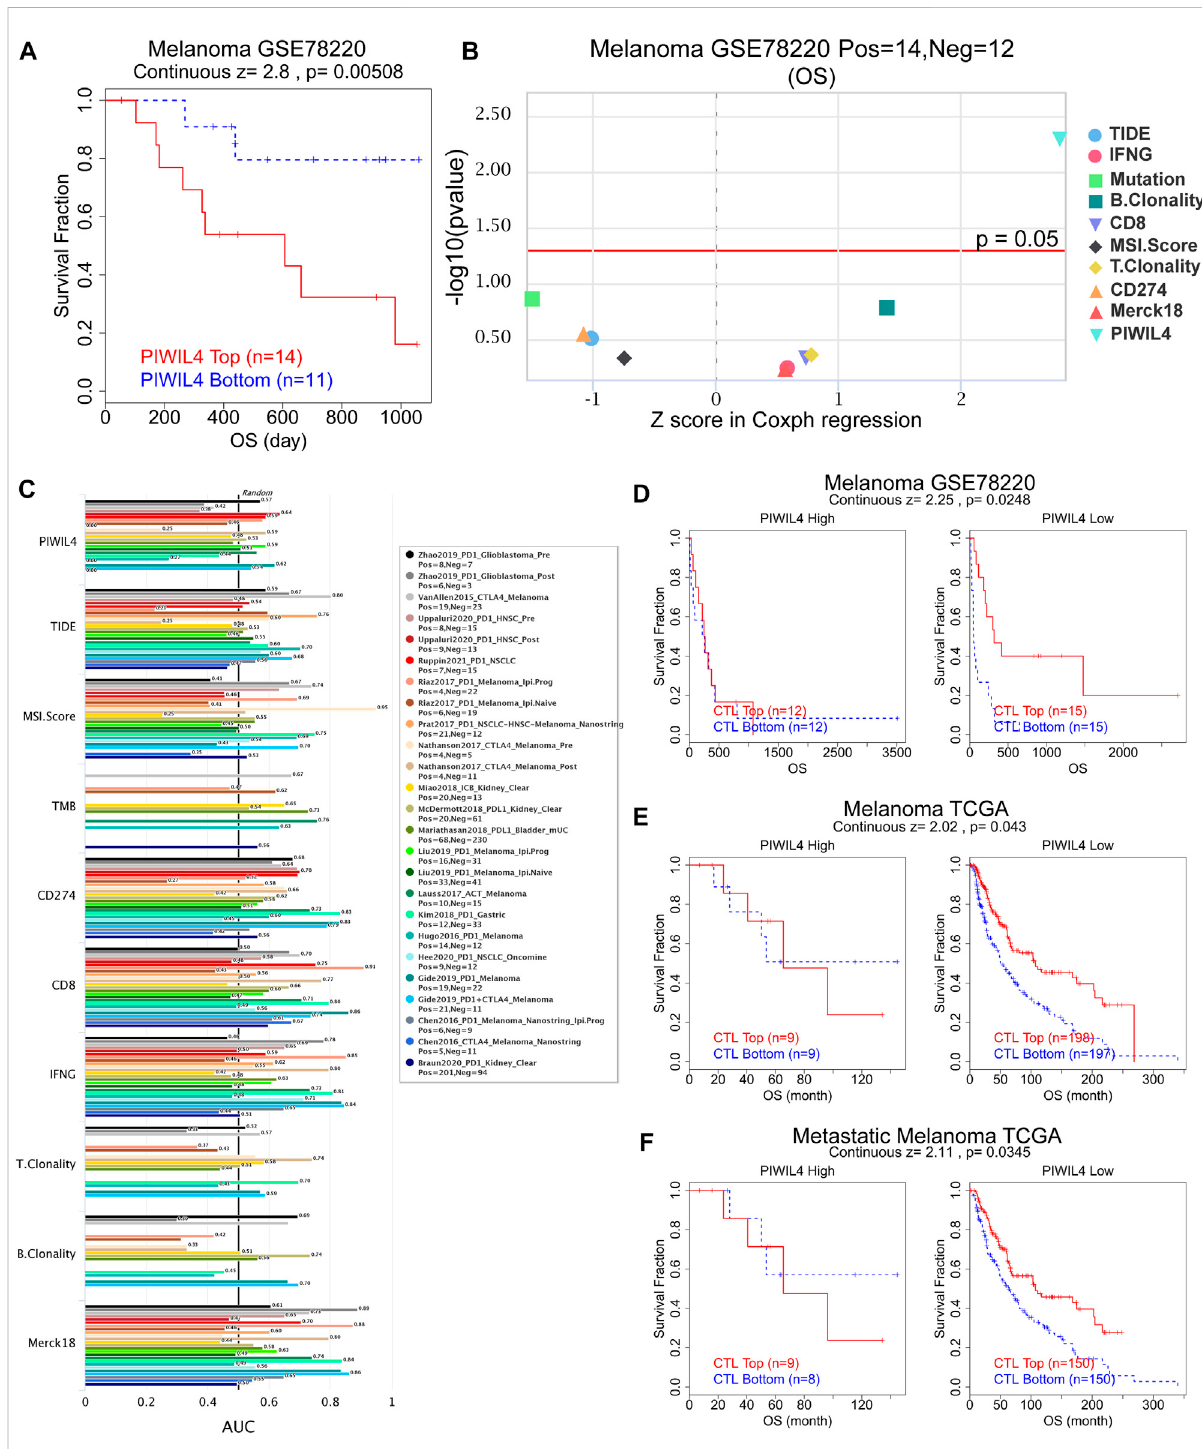
PIWIL4 predicted immunotherapy ef fi cacy. (A) The overall survival analysis of patients in melanoma when receiving PD1 inhibitor. (B) Z score in Coxphregressionanalysisofdifferentpredictorsofimmunotherapyinmelanoma. (C) ThepredictivecapabilityofPIWIL4forimmunotherapyef fi cacy in multiple human immunotherapy cohorts. (D – F) The overall survival analysis of patients in melanoma with different PIWIL4 expression and CTL